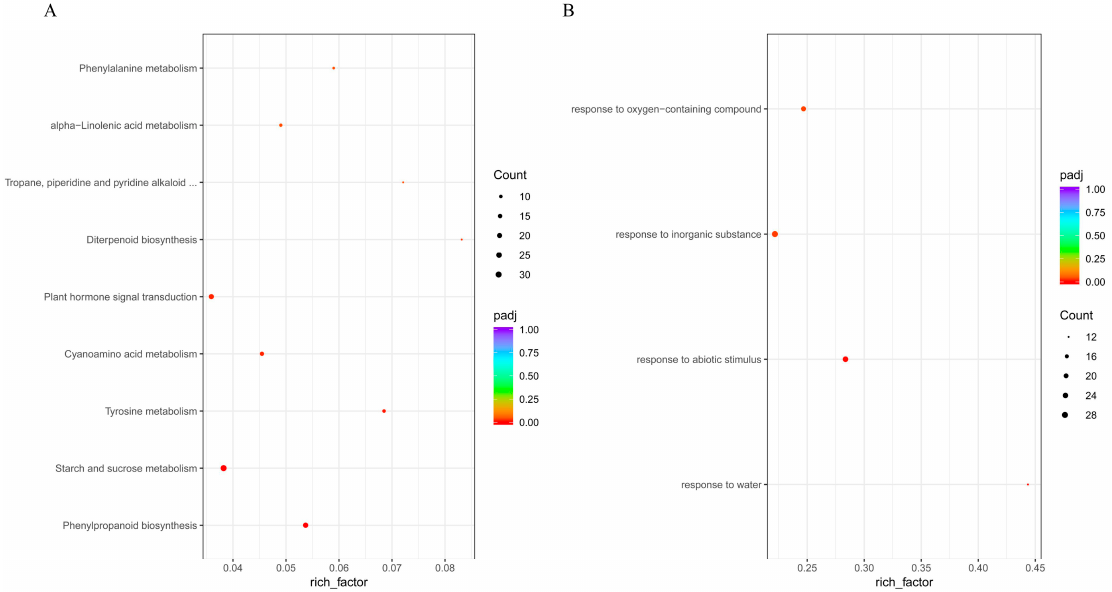
Figure 5. The KEGG and GO enrichment analyses of B. striata under CK and drought conditions. ( A ) The results of KEGG enrichment analysis; ( B ) the results of GO (biological process) enrichment analysis.